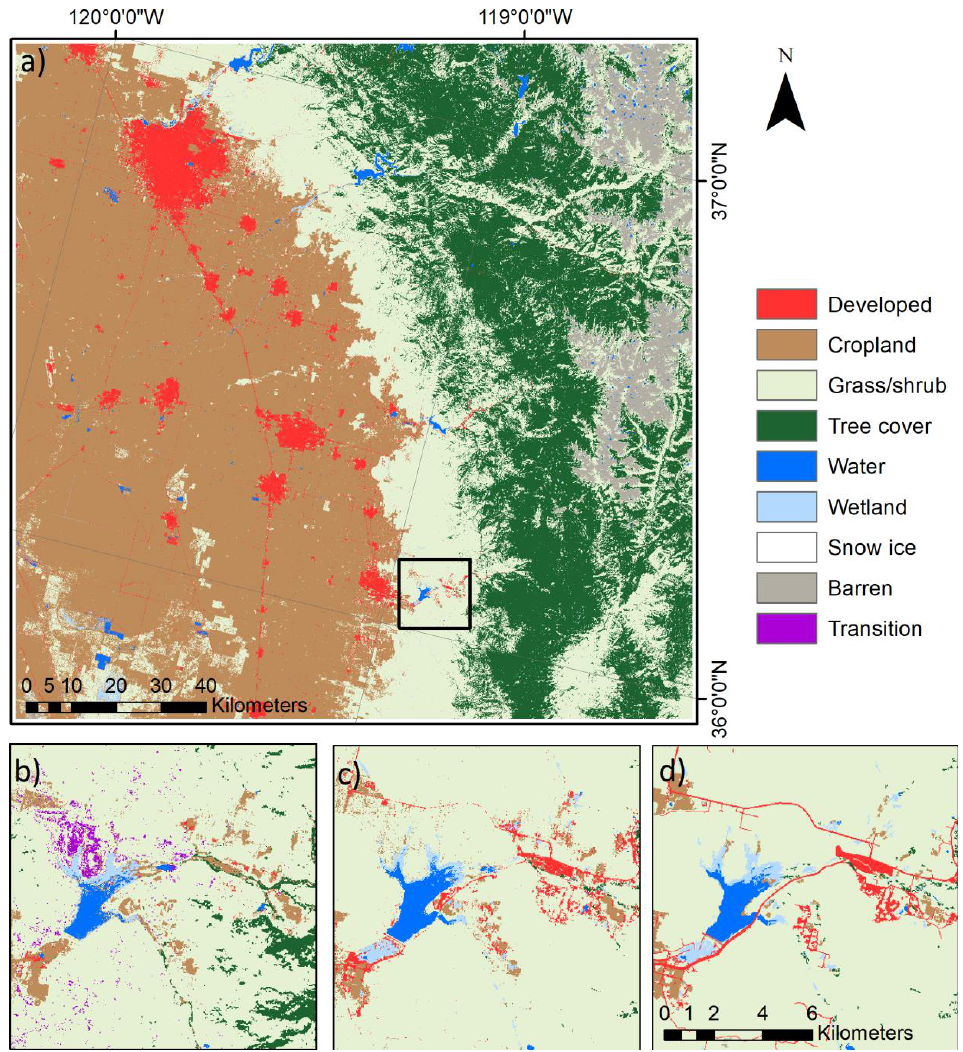
Figure 7. Demonstration of the classification results at the southern California site: ( a ) land